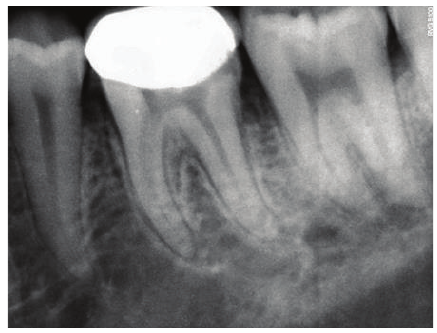
Figure 11: 18-month followup RVG 46.